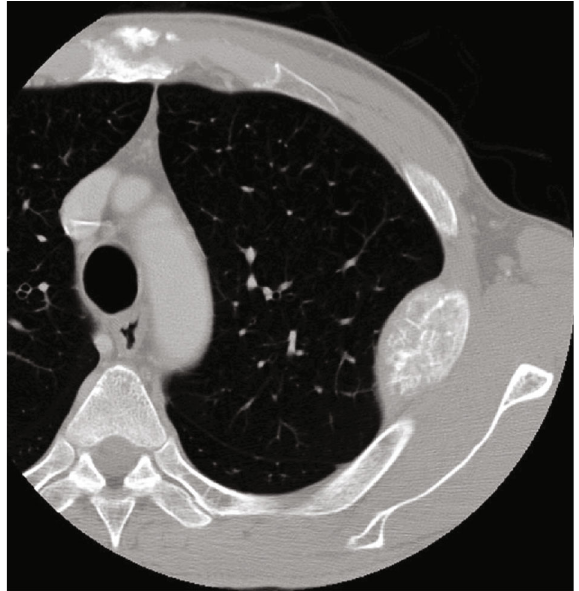
Figure 4: Computed tomography showing a tumor with cortical destruction and honeycomb-like calci fi cations in the 4th